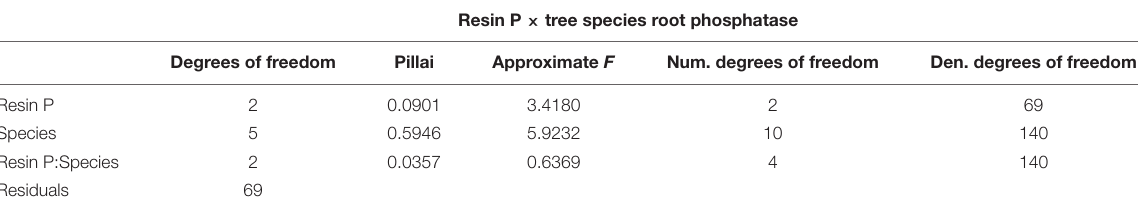
TABLE 3 | Resin P and tree species two-way repeated measures MANOVA of root PME and PDE.